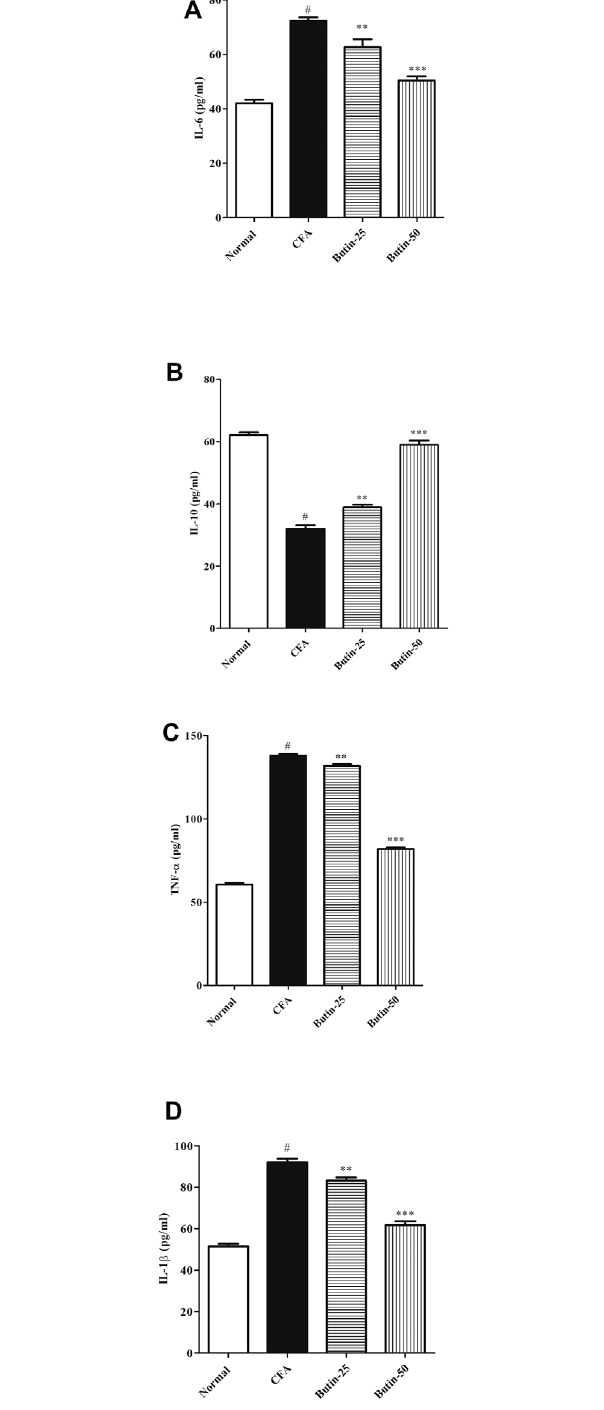
FIGURE6| Effectofbutinon (A) TNF- α , (B) IL-1 β , (C) IL-6,and (D) IL-10 levels in CFA-treated rats. Values are expressed in mean ± SEM ( n = 6). # p